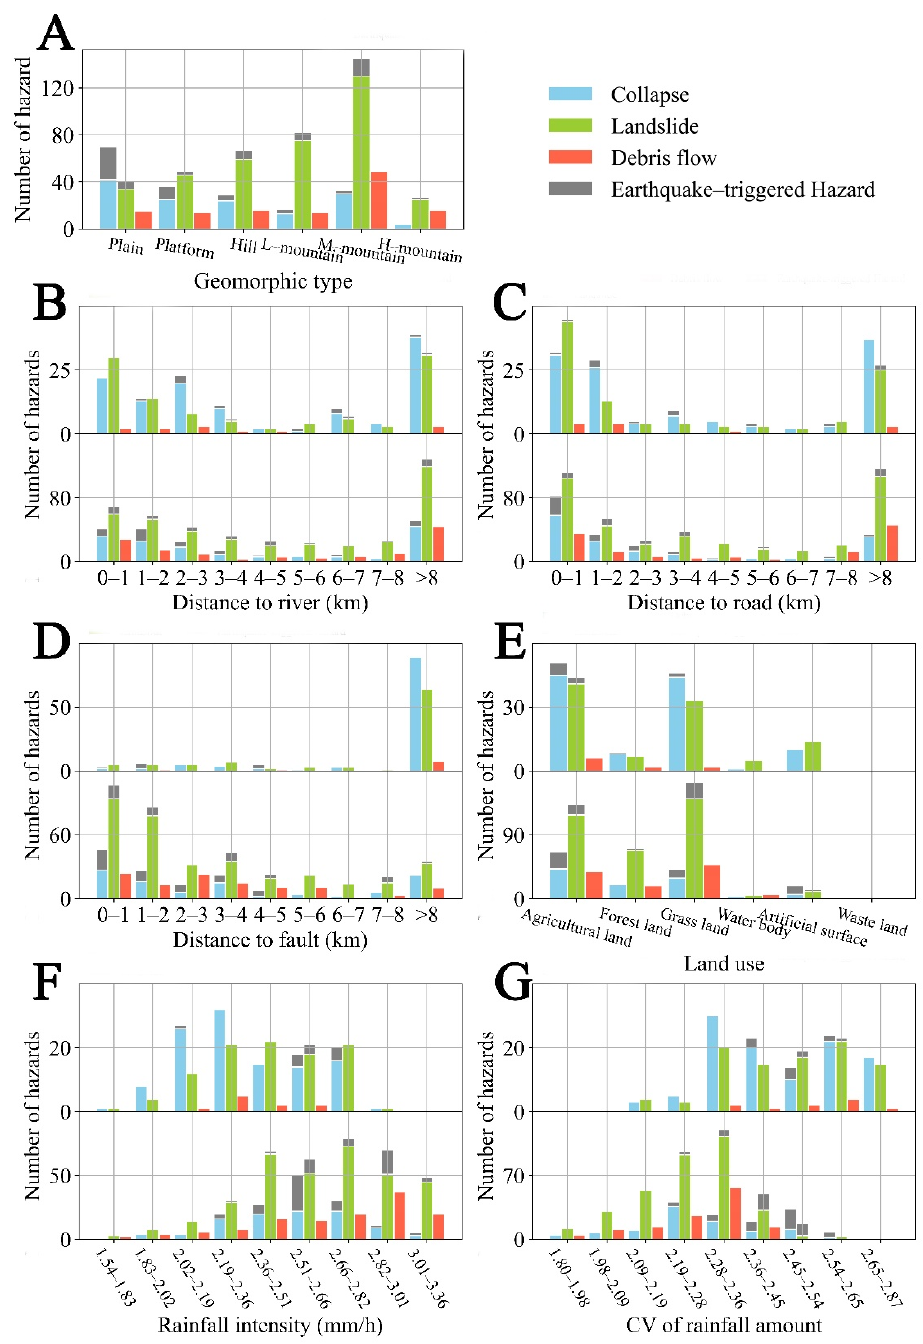
Figure 5. The relationships between hazards and potential impact factors (i.e., geographic types in Southern Shaanxi ( A ), distance to river ( B ), distance to road ( C ), fault ( D ), land use ( E ), the maximum 1 h rainfall intensity ( F ) and CV of rainfall amount ( G )). Note: The top of the figure represents Northern Shaanxi and the bottom represents Southern Shaanxi; The L-, M- and H- mountain in ( A ) means low-relief mountain, medium-relief mountain and high-relief mountain.